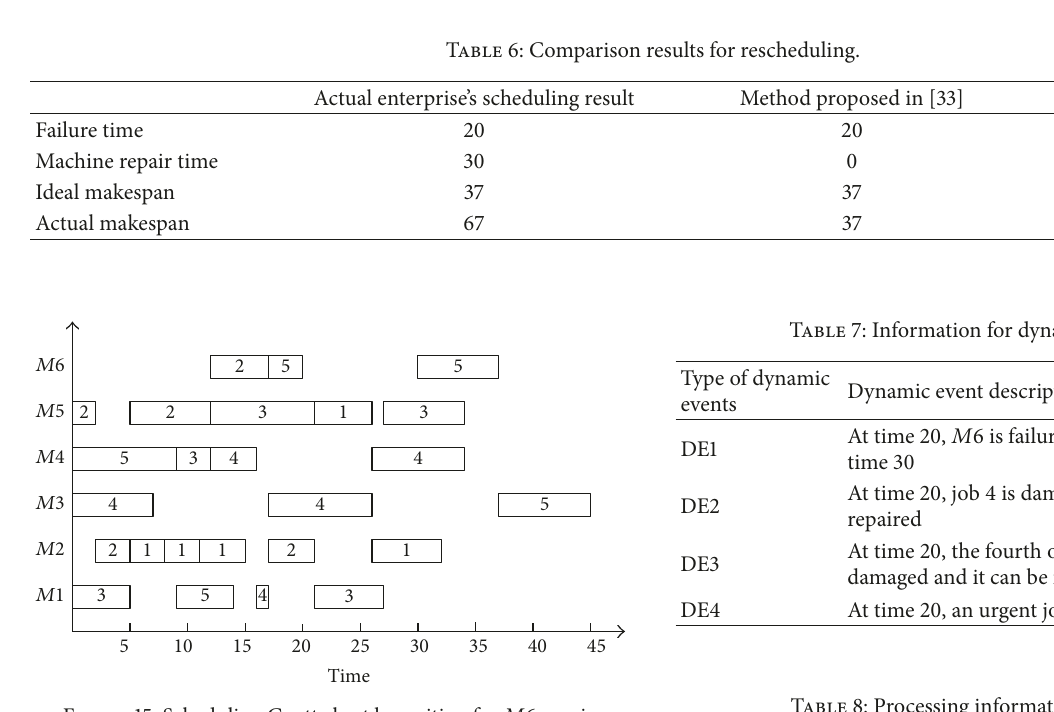
Figure 15: Scheduling Gantt chart by waiting for 𝑀6 repair.